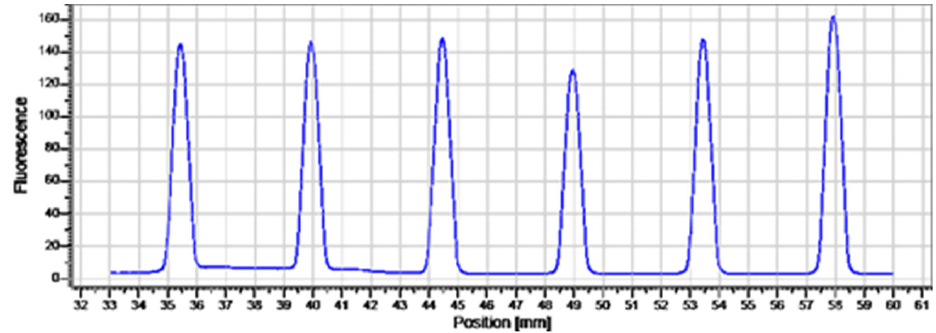
Figure 7. Fluorescence of bound and unbound state after denaturation of the TET1 protein.